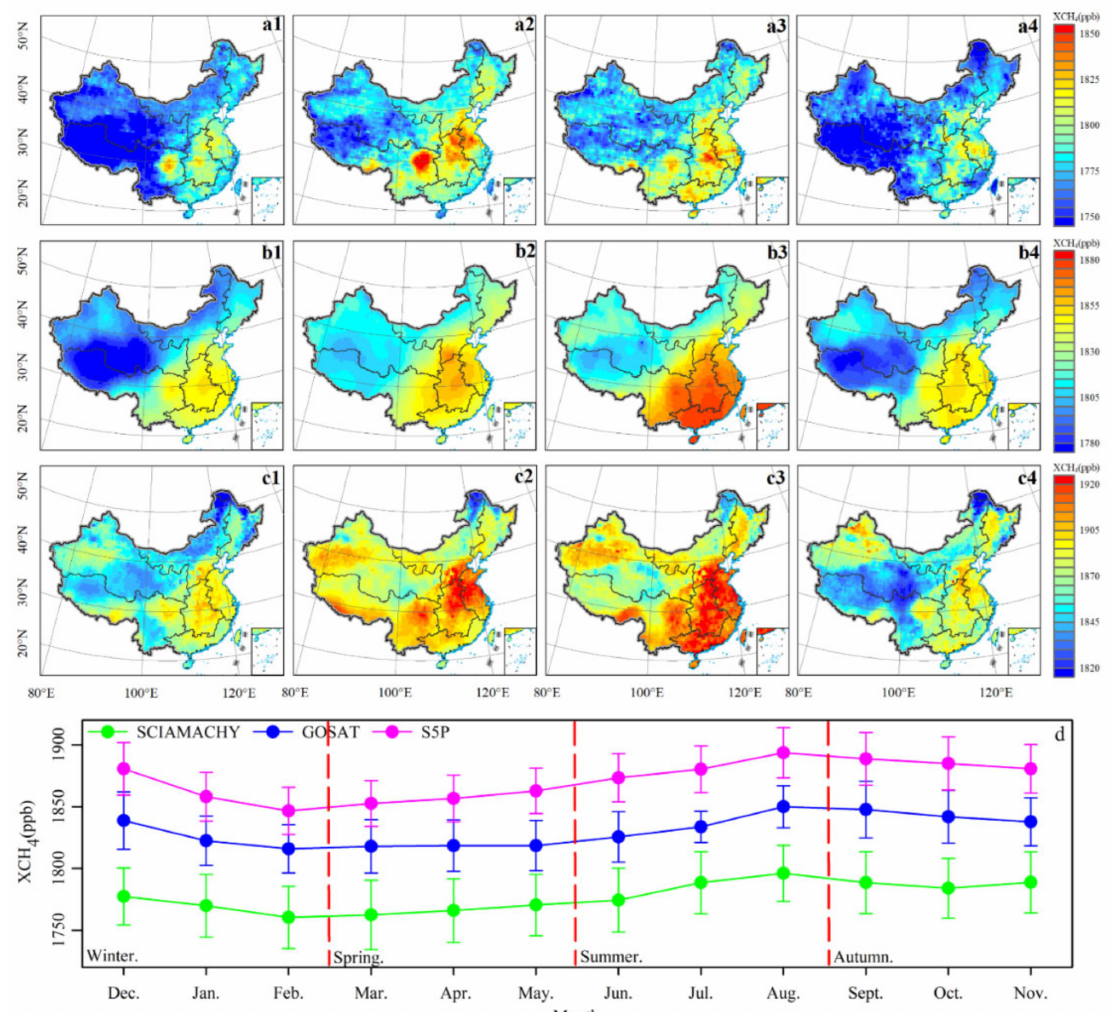
Figure 7. Spatial distributions of the seasonal averages of XCH 4 concentrations across China in the four seasons from SCIAMACHY (2003–2010), GOSAT (2011–2018), and S5P (2019–2021). ( a1 – a4 ) Spring, summer, autumn, and winter data from SCIAMACHY; ( b1 – b4 ) spring, summer, autumn, and winter data from GOSAT; ( c1 – c4 ) spring, summer, autumn, and winter data from S5P; ( d ) monthly variations of XCH 4 concentrations over